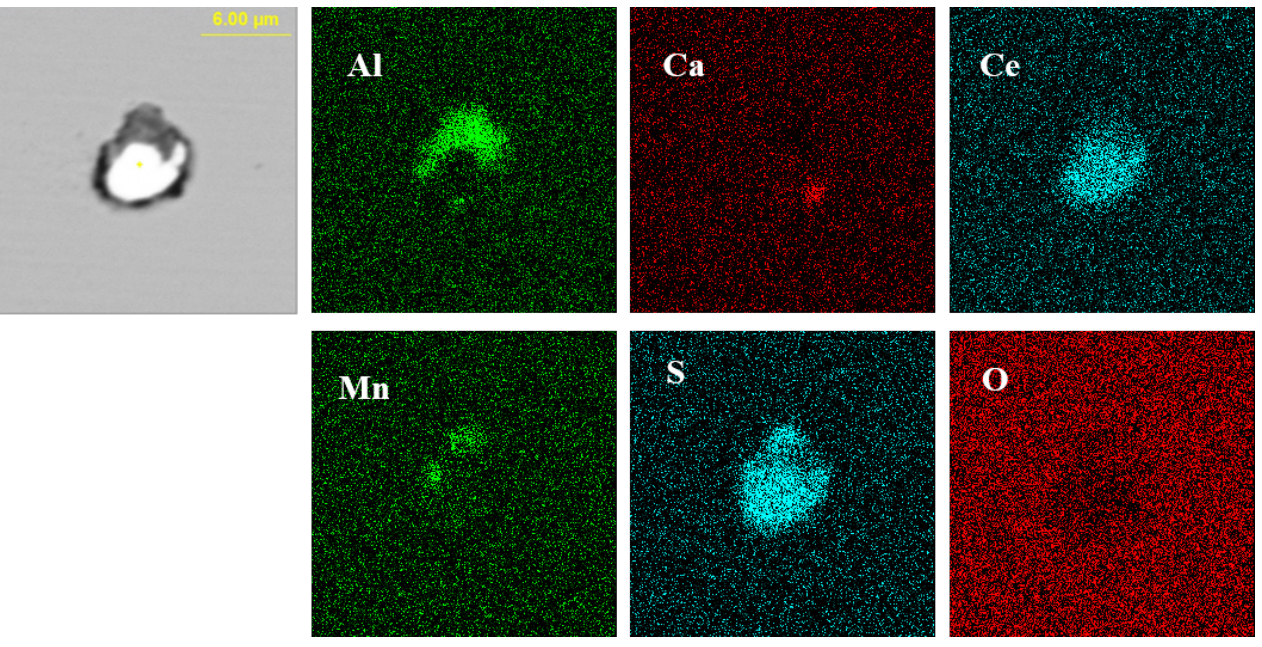
Figure 5. Elemental mapping of a typical inclusion in the steel with 14 ppm Ce content.